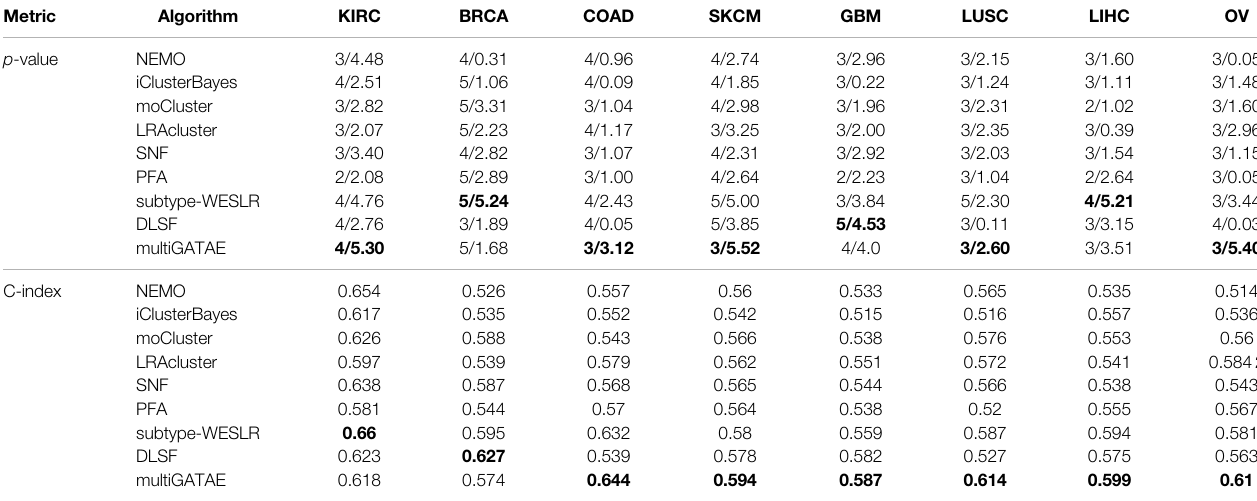
Bold values indicates the best